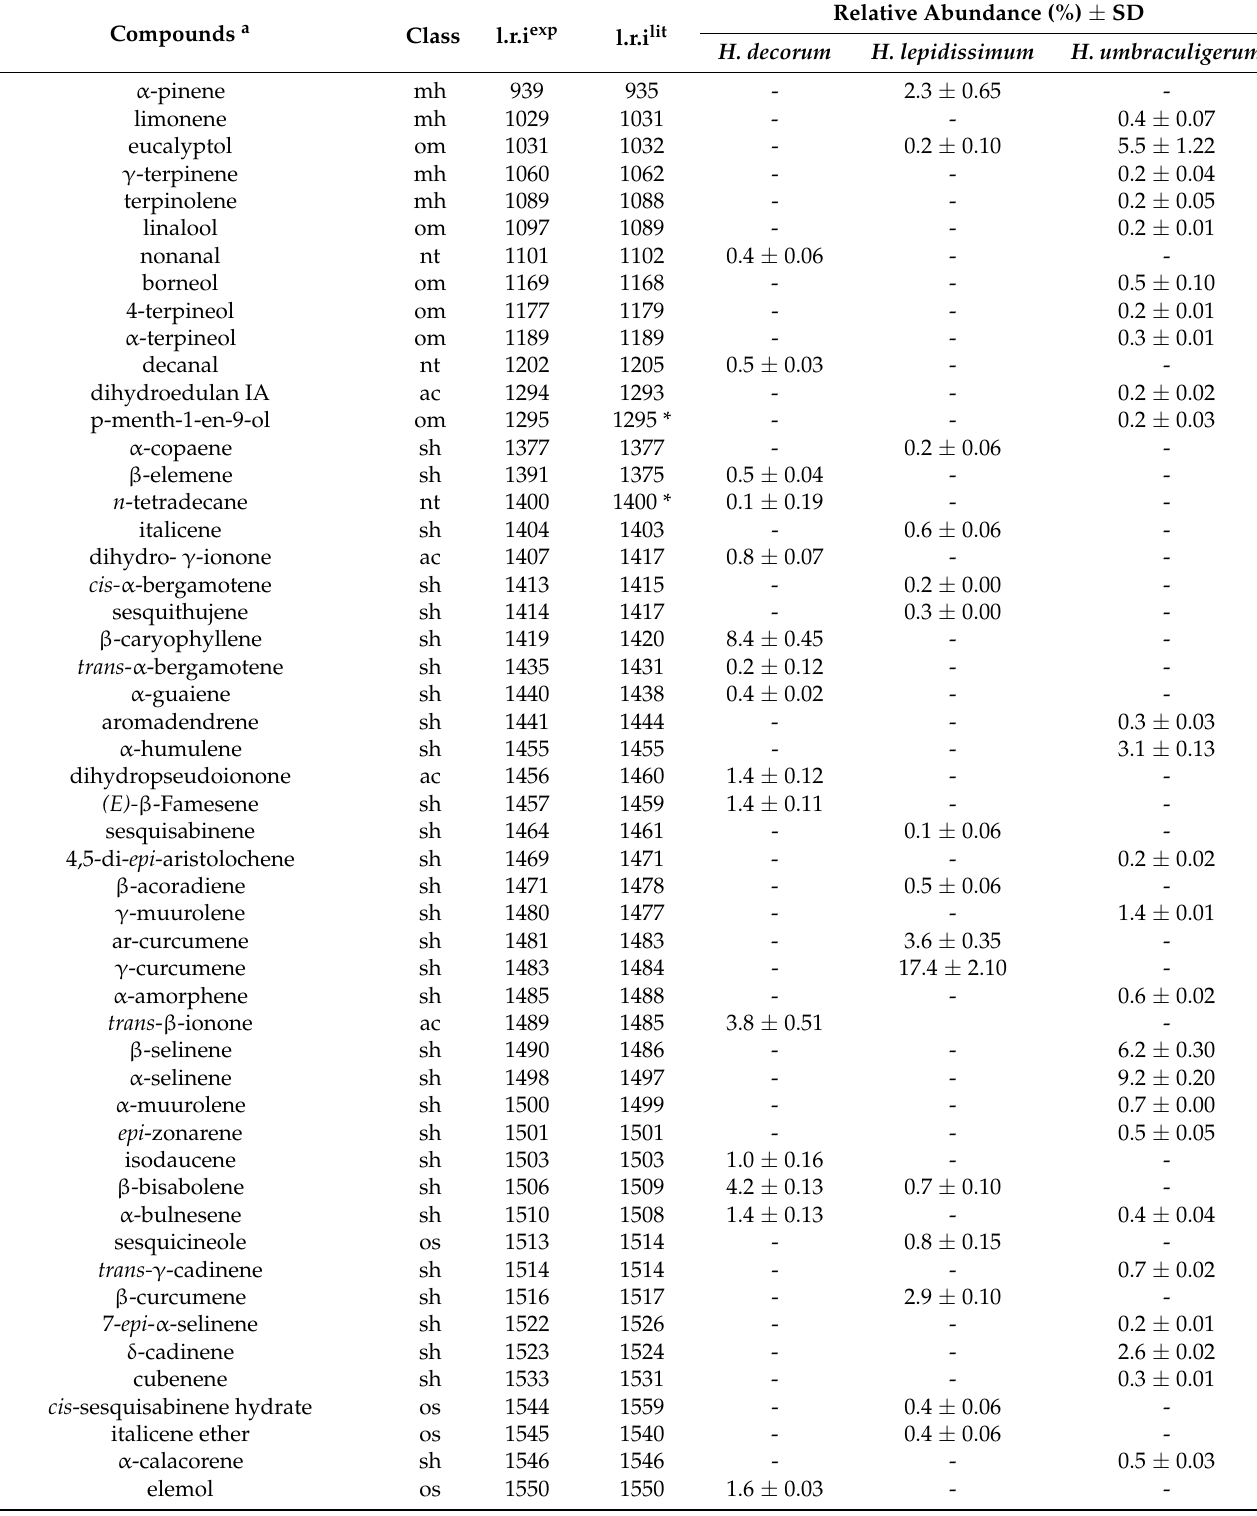
Table 2. Complete chemical composition and hydrodistillation yield of essential oils obtained from dried aerial parts of three analyzed Helichrysum